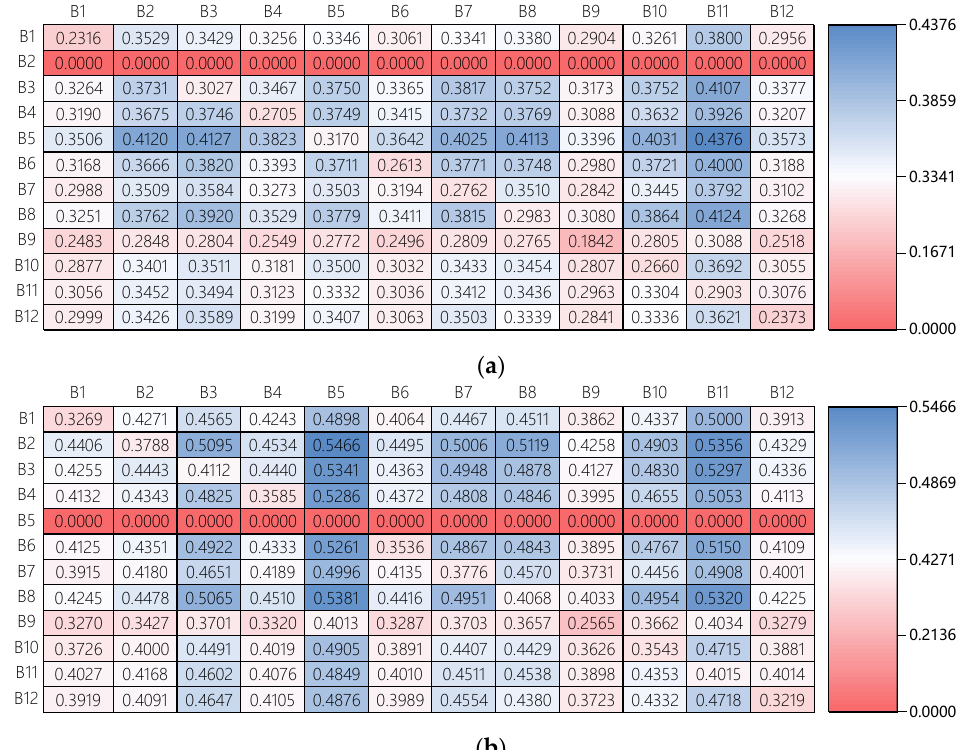
Figure 5. Prominence-relation maps for scenario ( a ) and scenario ( b ).